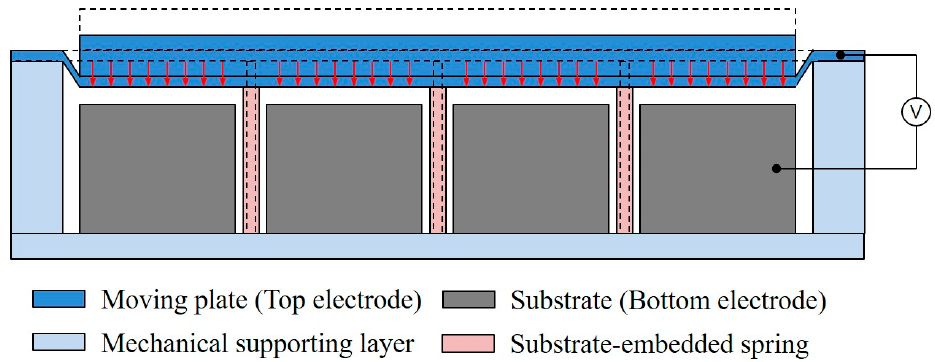
Figure 2. Cross-sectional schematic drawings of an element of CMUT with substrate-embedded springs. The dashed line represents the initial state of the CMUT with substrate-embedded springs before applying DC and AC voltage.